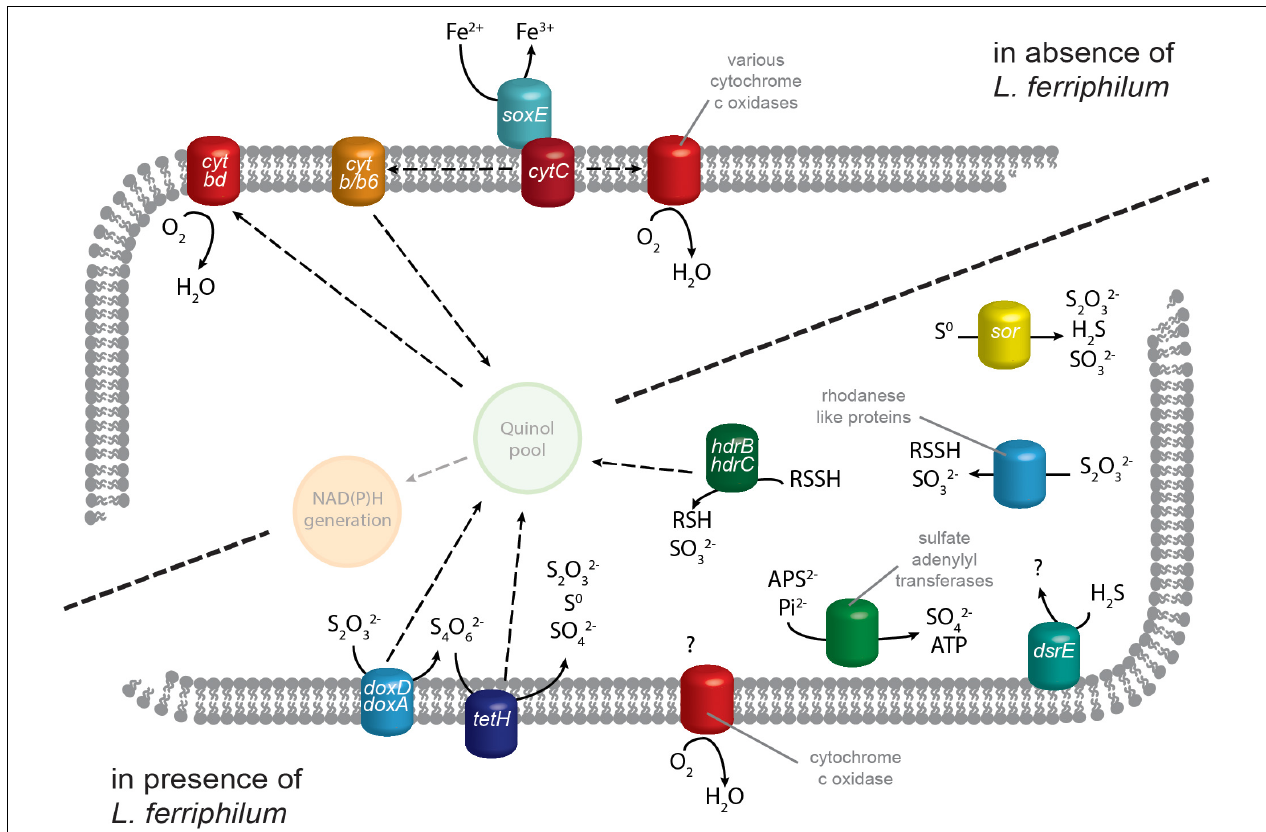
FIGURE 3 | Proposed model of S. thermosulfidooxidans transcript regulation of genes related to energy generation. Iron oxidation systems and electron transport by cytochromes has a greater number of RNA transcripts in the absence of the strong iron oxidizer L. ferriphilum . In its presence, S. thermosulfidooxidans instead has higher transcript numbers for genes contributing to ISC oxidation plus one cytochrome c oxidase complex. Quinone pool and NAD(P)H generation are depicted translucently for comprehension, but corresponding genes were not analyzed in this study. Solid arrows represent metabolic reactions while dashed arrows indicate the relocation of